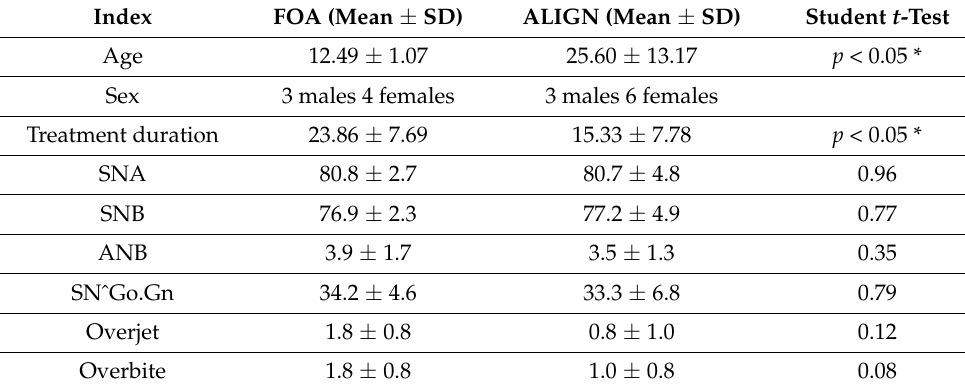
Table 1. Mean values and standard deviation (SD) relating to age, orthodontic characteristics, and duration of the treatment in FOA and ALIGN group. Significant differences between groups at t -Test were set at 5% ( p < 0.05). p < 0.05 *. Index FOA (Mean ± SD) ALIGN (Mean ± SD)